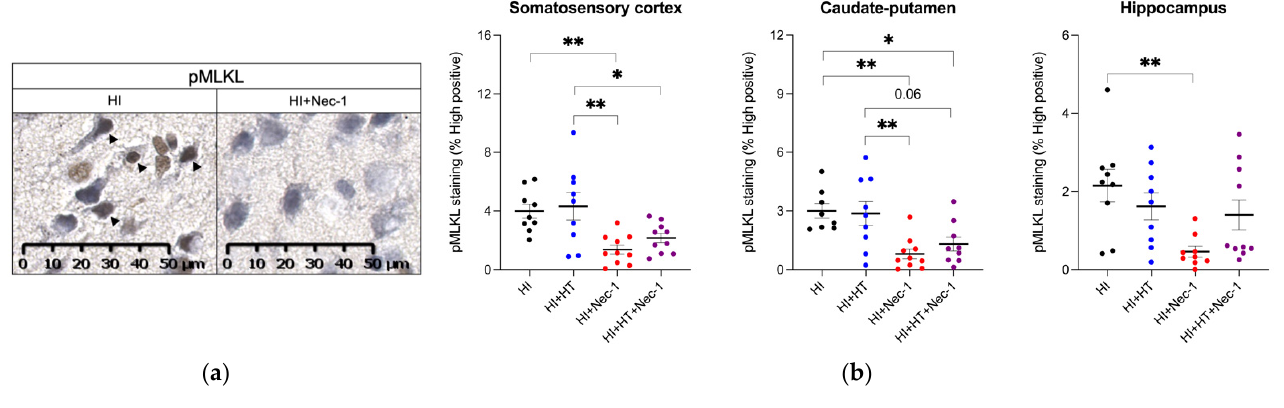
Figure 3. pMLKL expression in the brain at 5 h post-HI from pups exposed to HI ± Nec-1 ± HT. ( a ) Representative image of pMLKL staining in the somatosensory cortex of HI compared to HI+HT+Nec-1-exposed animals. ( b ) Percentage of pMLKL staining compared to CTL within the somatosensory cortex, caudate-putamen, and hippocampus in HI ± Nec-1 ± HT conditions. The num- ber (n) of rats used was n = 7–8 per conditions from 8 litters. The bars indicate the mean ± SEM. * p ≤ 0.05; ** p ≤ 0.01, ANOVA with Tukey HSD’s multiple comparisons tests. Abbreviations: CTL: control; HI: hypoxia-ischemia, HT: hypothermia; Nec-1: necrostatin-1; pMLKL: phosphorylated forms of the mixed-lineage kinase domain-like